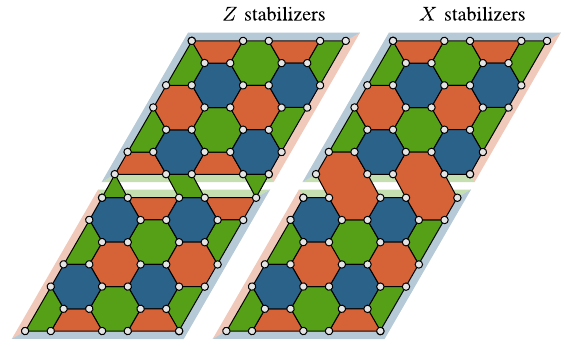
FIG. 21. Stabilizers that are measured to obtain the ZZ parity between two logical qubits using lattice surgery. In contrast to usual color-code stabilizer measurements, lattice surgery requires measurements where the support of X and Z stabilizers does not coincide. The left panel shows the required Z stabilizers, and the right panel the X stabilizers, which differ along the shared boundary. To obtain the XX parity between two qubits, one simply has to swap Z ↔ X in the